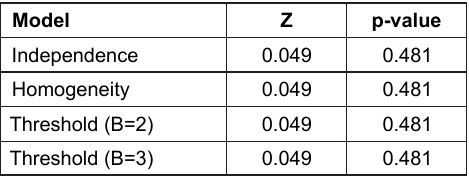
Table 47. Tests for randomness of collars across groups for the 2015 Tuktoyaktuk Peninsula herd